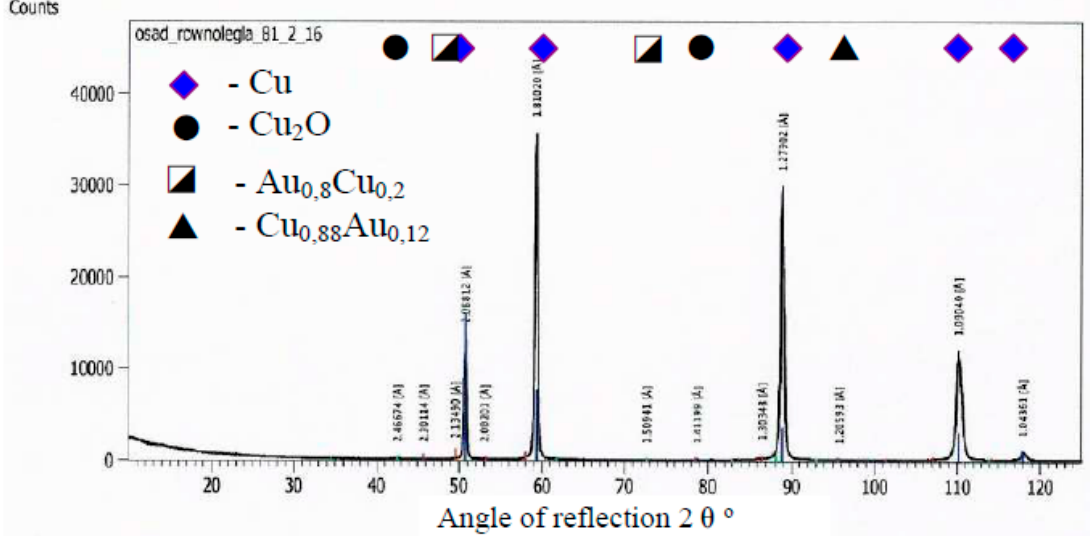
Materials 2019 , 12 , x FOR PEER REVIEW Figure 7. A di ff ractogram of the surface of a copper electrode galvanized and coated by gold. Figure 7. A diffractogram of the surface of a copper electrode galvanized and coated by gold.